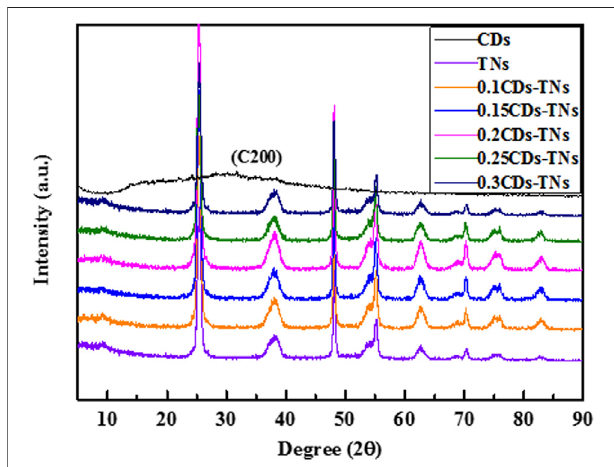
Frontiers in Chemistry |